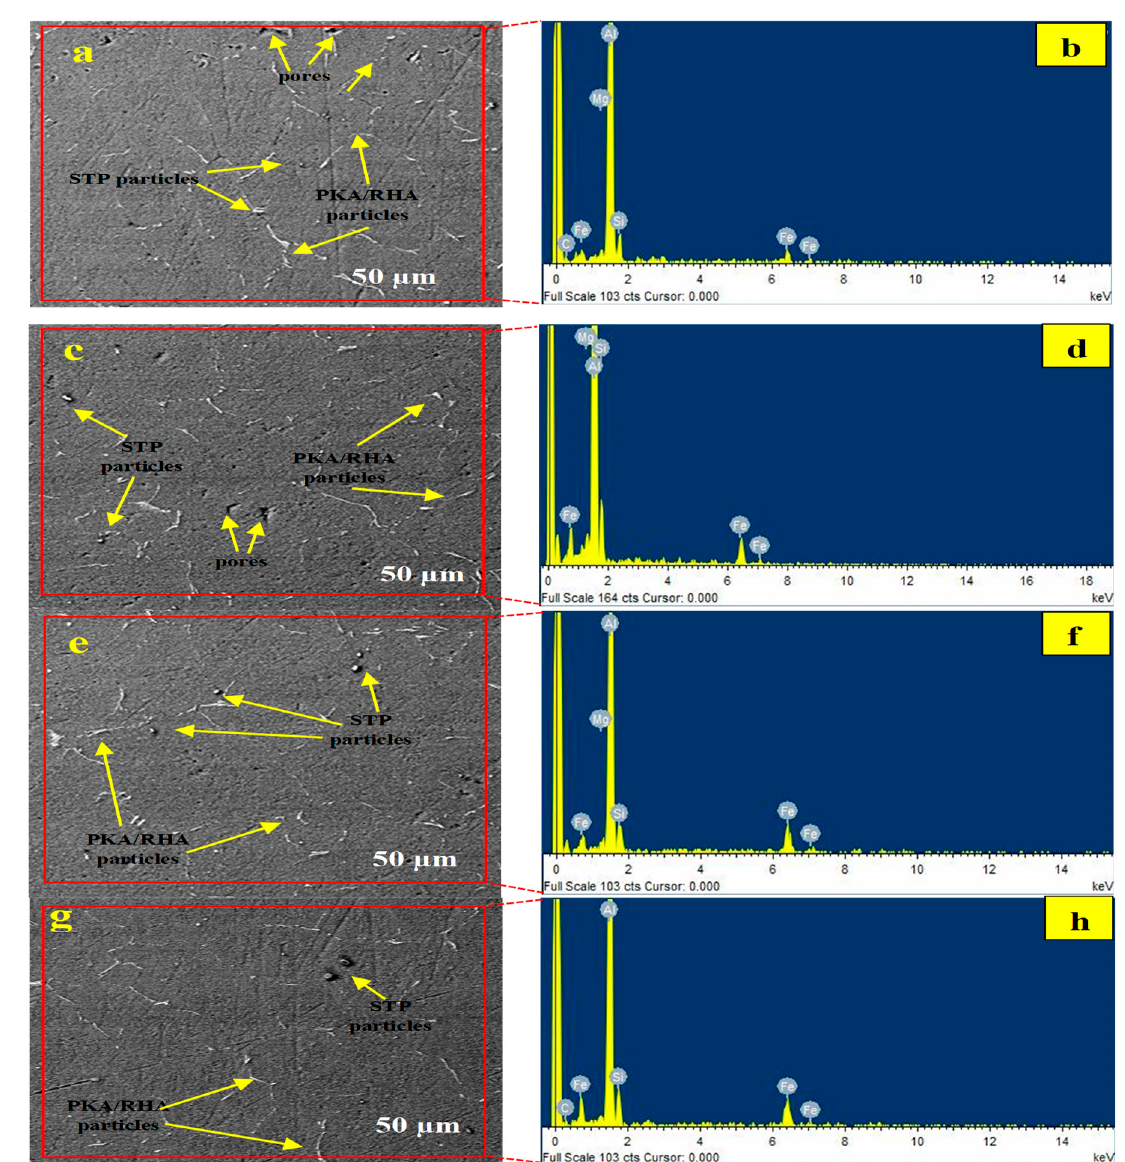
Figure 4. Morphology and EDS analysis of specimens prepared at 700 °C containing ( a , b ) 2% PKA and 4% RHA ( c , d ) 4% PKA and 2% RHA; specimens prepared at 800 °C containing ( e , f ) 2% PKA and 6% RHA ( g , h ) 6% PKA and 2% RHA.